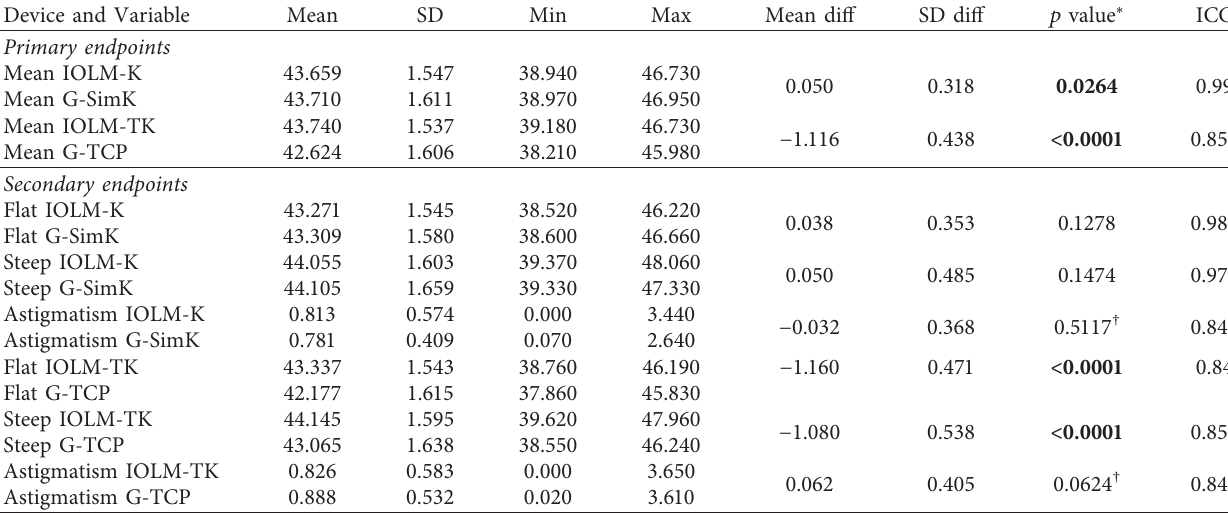
Table 1: Mean differences between